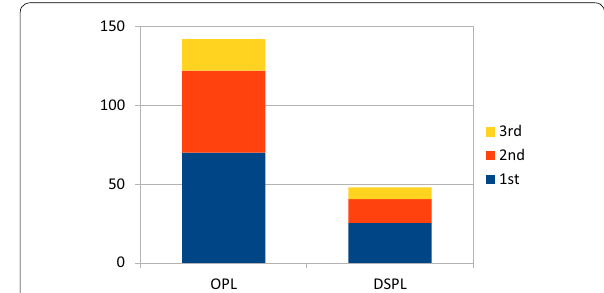
Fig. 25 Total points of top three teams for GPSR in 2017 (Obtained from [48])